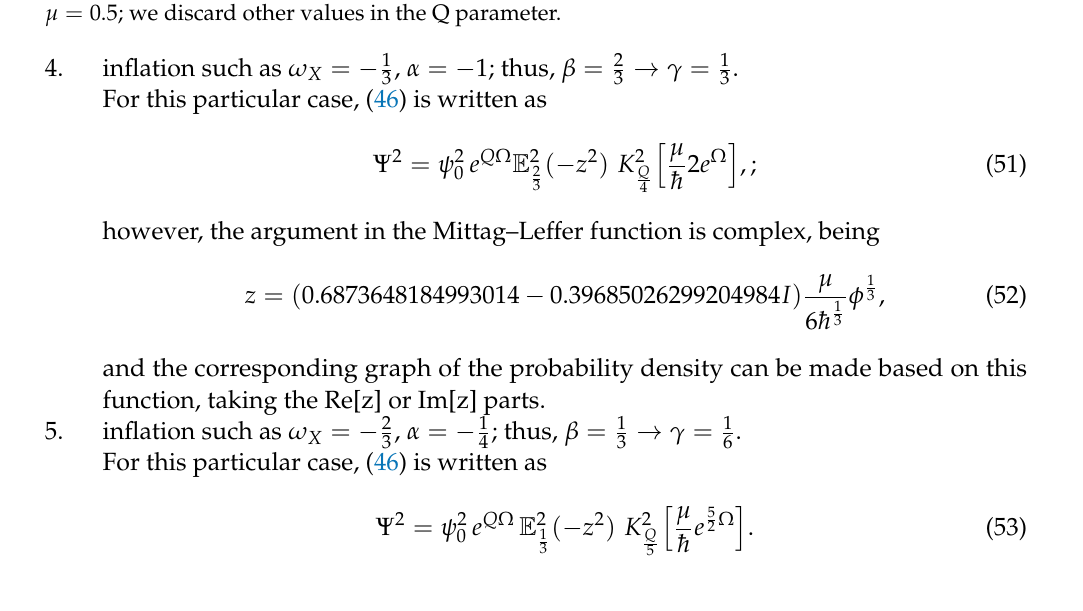
Figure 3. In the dust era, we have the corresponding solution B + with the modified Bessel function K ν and B − , the ordinary Bessel function of the Equation (50), considering different values in the order parameter Q = − 1,0,1, from top to bottom, respectively. We consider the value for the parameter µ = 0.5; we discard other values in the Q